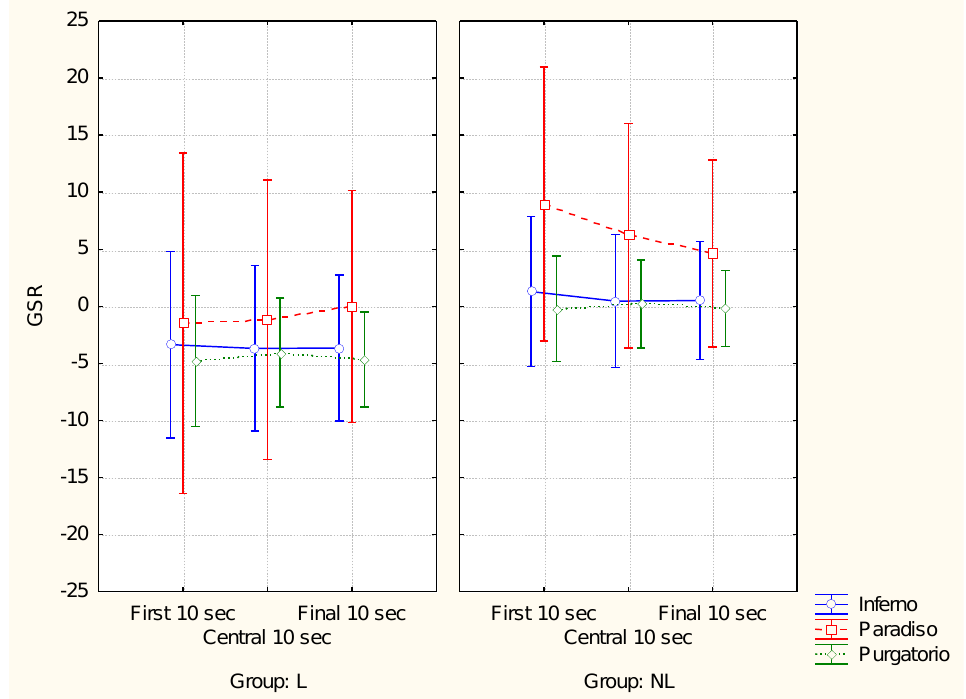
Figure 1. Graph representing the significant interaction between the factors: CANTICA (Inferno, Paradiso and Purgatorio), TIME POINT (first, central and final 10 s segments) and GROUP (L: Literature students; NL: Non-Literature students) resulting from the ANOVA analysis for the Galvanic Skin Response (GSR) index. Vertical bars denote 0.95 confidence interval.